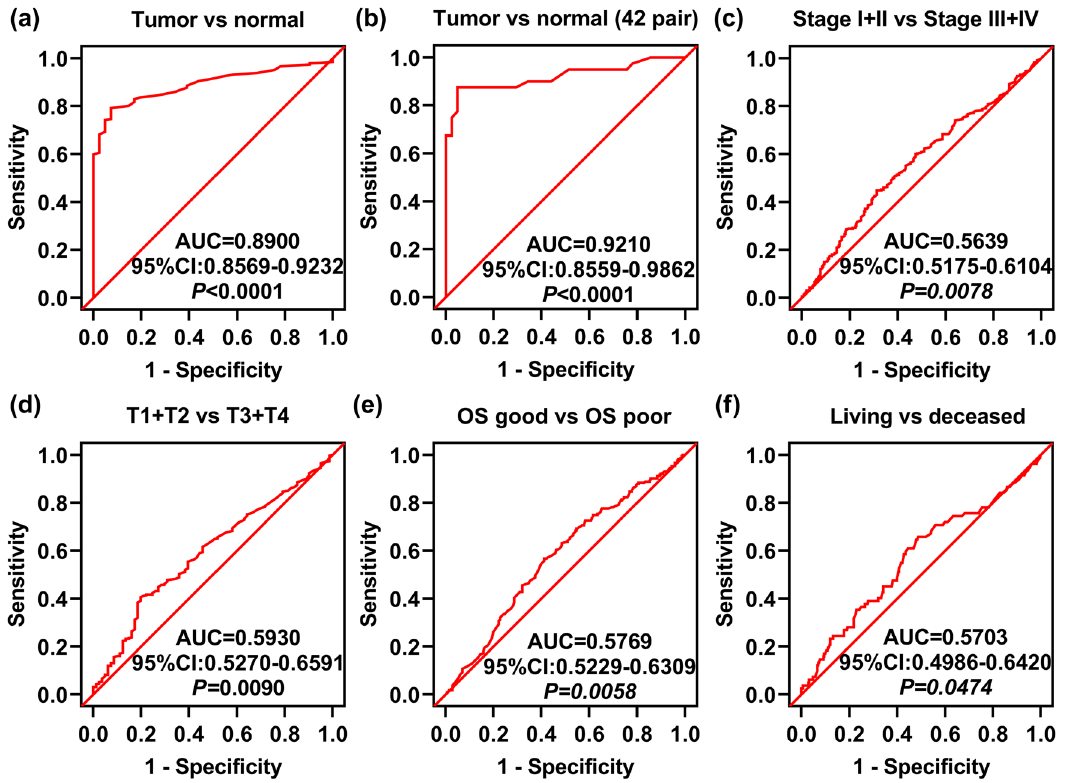
Figure 3: ROC curve analysis of OXTR expression related to the indicated clinical parameters in COAD patients. ( a ) The ROC curve analysis of COAD tissue and unpaired normal tissue. ( b ) The ROC curve analysis of COAD tissues and paired normal tissues. ( c – f ) ROC curve analysis of TNM stage ( c ) , T stage ( d ) , OS ( e ) , and living status ( f ) . AUC: area under the curve; OS: overall